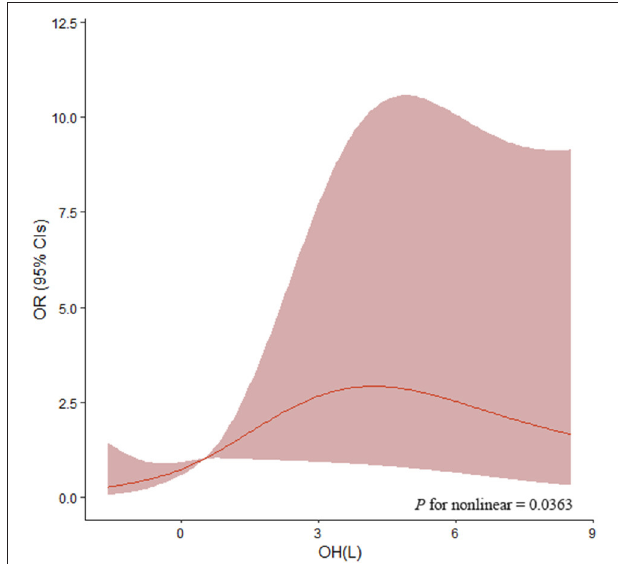
FIGURE 3 | Association of OH with OR of LVH by restricted cubic splines. Restricted cubic splines were plotted using four default knots at the 20th, 40th, 60th, and 80th percentiles. ORs were adjusted for age, gender, diabetes, BMI, SBP, hemoglobin, serum albumin, eGFR, and logarithmic transformation of urinary sodium and urinary protein. The P -value for non-linear association was 0.0363. OH, overhydration; OR, odds ratio; BMI, body mass index; SBP, systolic blood pressure; eGFR, estimated glomerular filtration